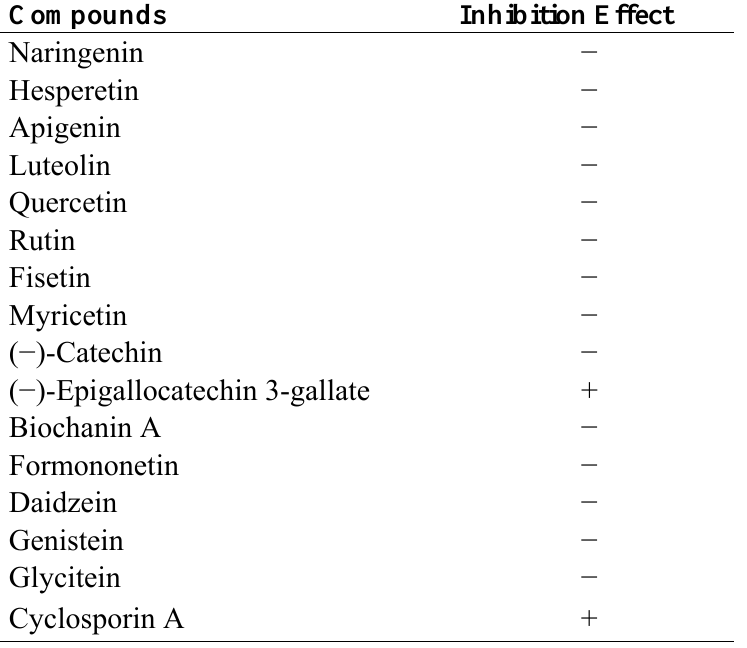
Table 2. The effects of flavonoid compounds and cyclosporine A on the binding inhibition of viral protein NS5B used in this